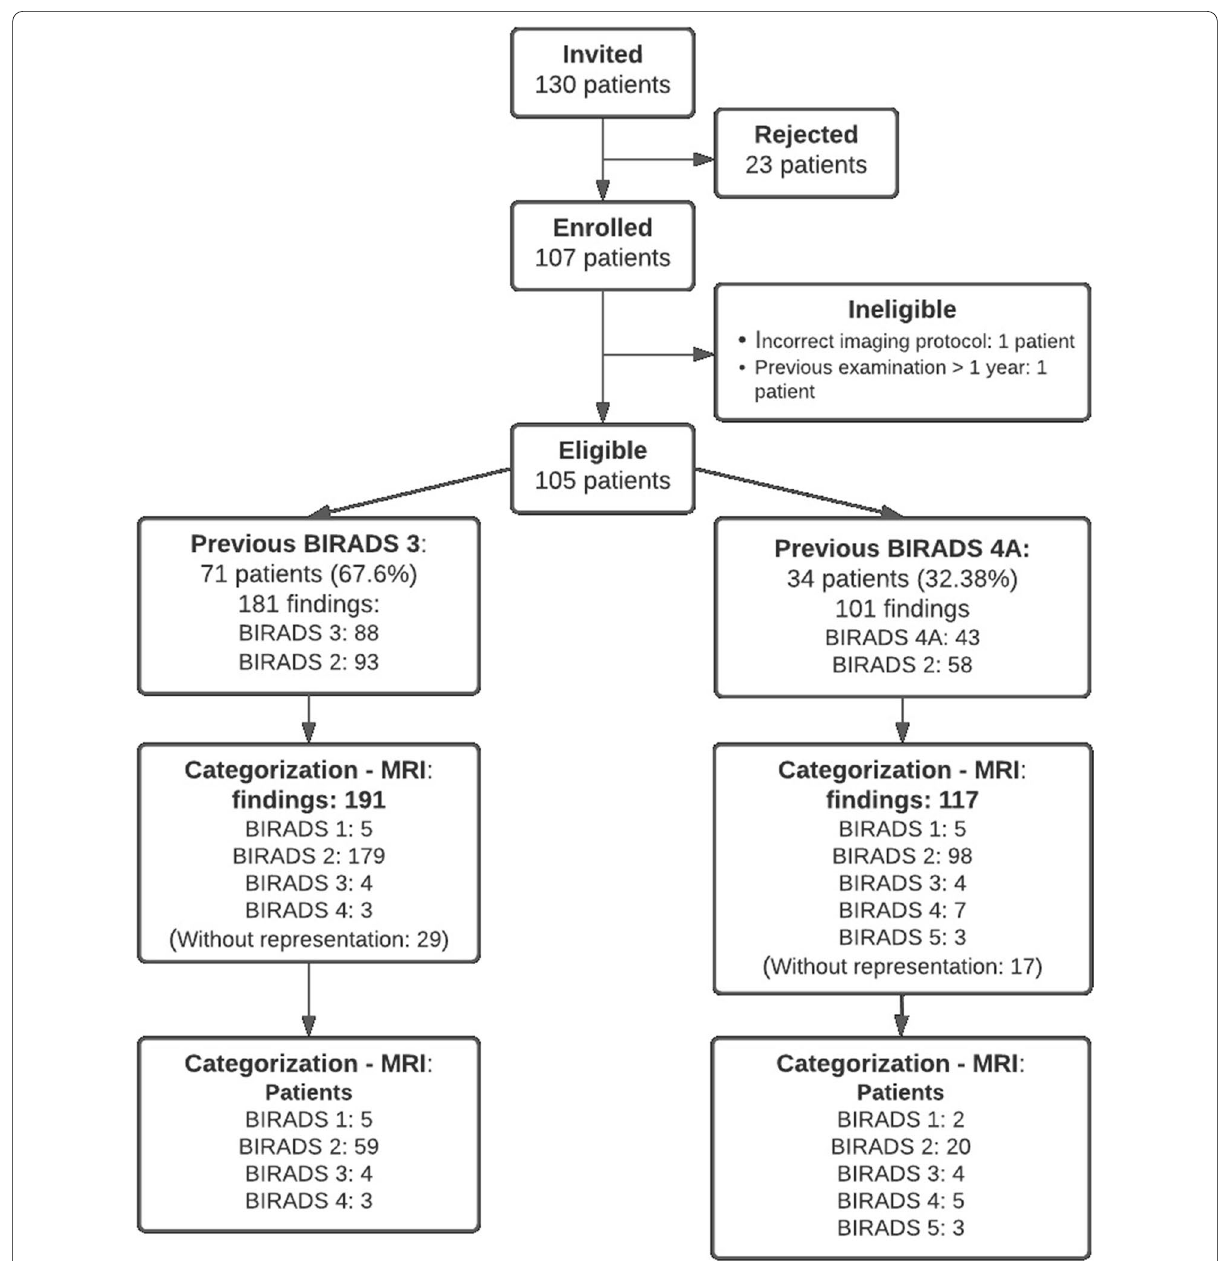
Fig. 1 Patient selection flowchart and final findings stratified by BIRADS